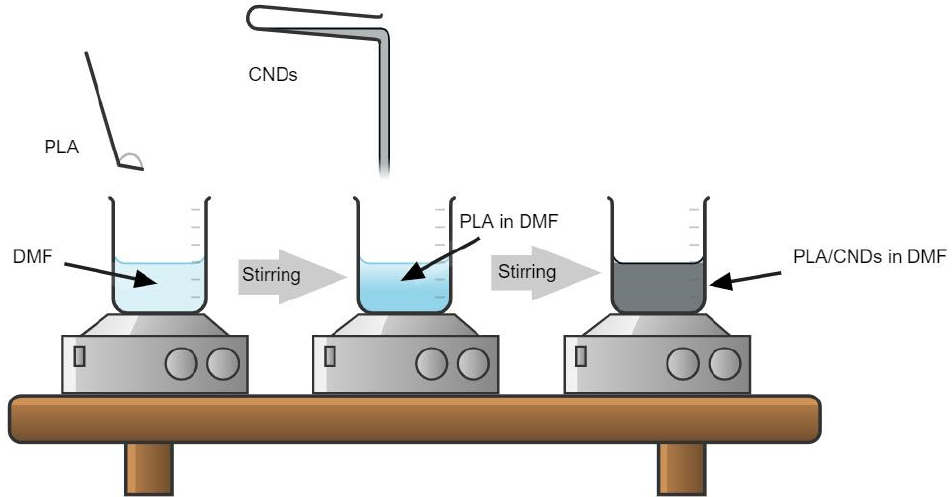
Figure 1. Preparation of solution for